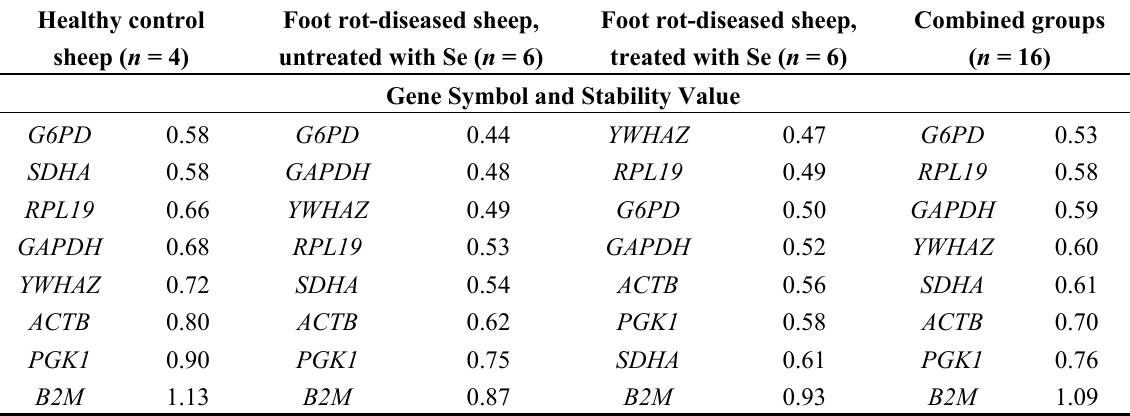
Table 6. The best choices for neutrophil reference genes were G6PD , YWHAZ , GAPDH and RPL19 . Again, SDHA performed well in healthy sheep and FR-diseased sheep that were not treated with Se, but after Se treatment of FR-diseased sheep, it ranked near the bottom of the rank order. As for geNorm, NormFinder and BestKeeper analyses, three of the candidate neutrophil reference genes would be excluded as reference genes from consideration, as they ranked consistently at or near the bottom of the rank order: PGK1 , ACTB and B2M . Table 6. Stability ranking of candidate reference genes in healthy control and foot rot-affected sheep, with or without selenium (Se) treatment, and in combined groups, by the comparative delta Cq method (lower stability values indicate more stable gene